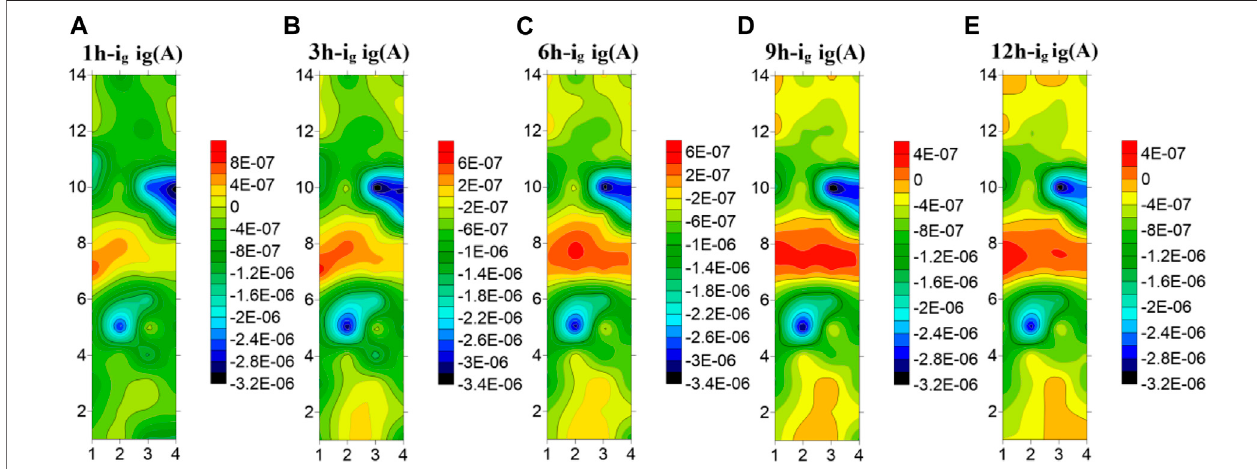
FIGURE 7 | Microelectrode array test results of titanium alloy welded joint soaked in seawater for 12 h at 25 ° C (A) 1 h (B) 3 h (C) 6 h (D) 9 h (E) 12 h.